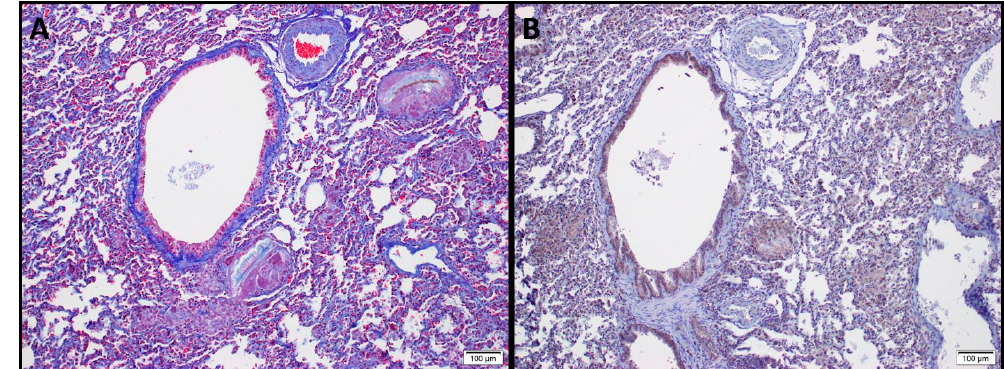
Figure 3. Sections from rabbit lungs 60 days after intratracheal instillation of 0.1 N –hydrochloric acid. ( A ) Masson’s Trichrome staining depicting fibrotic lesions, loss of alveolar architecture, peribronchial, and perivascular collagen deposition. ( B ) HSP90 β immunohistostaining of the same section displaying upregulation of HSP90 β (in brown) within the fibrotic tissue and in peribronchial regions.